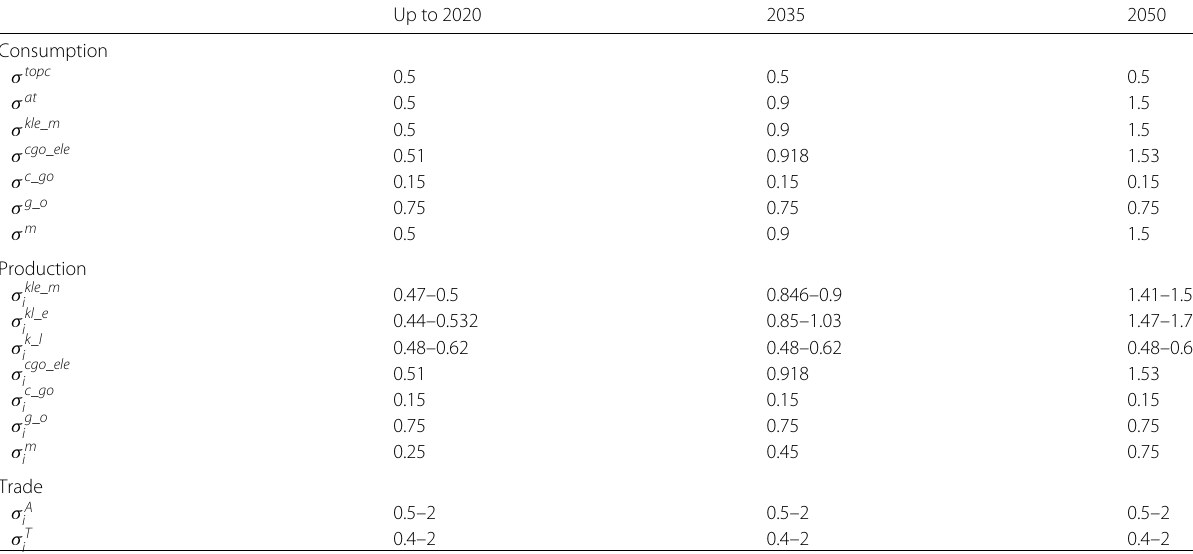
Table 11 Elasticities of substitution in utility and production functions and